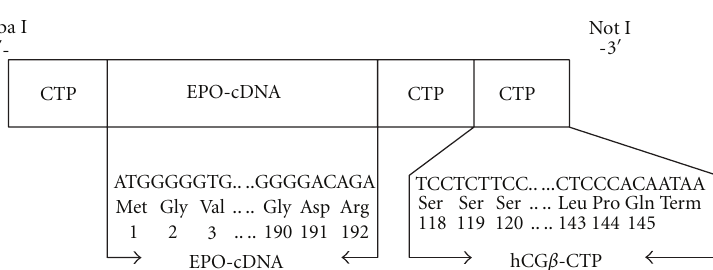
Figure 1: Construction of EPO-(CTP) 3 chimeric gene. The chimeric gene contains the cDNA of human erythropoietin and three hCG β carboxyl-terminal peptides that were ligated to the N -terminal (one) and to C -terminal (two) coding sequences.